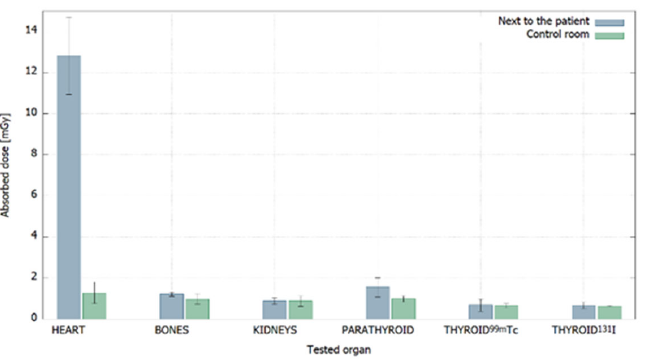
Figure 4. Comparison of the doses absorbed by TLDs located next to the patient and in the control room for all procedures.